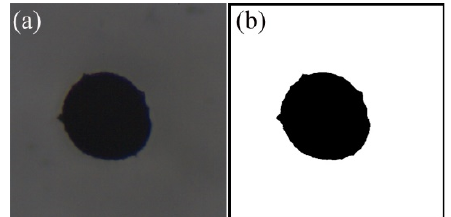
Figure 3. The example of image and data processing: ( a ) original image; ( b ) binarized image. For the combustion characteristics of the Mg microparticles, their propagation dis- placement and flame sizes can be measured by contrasting the images. The propagation velocity and diffusion ratio can be calculated based on the measured sizes and the